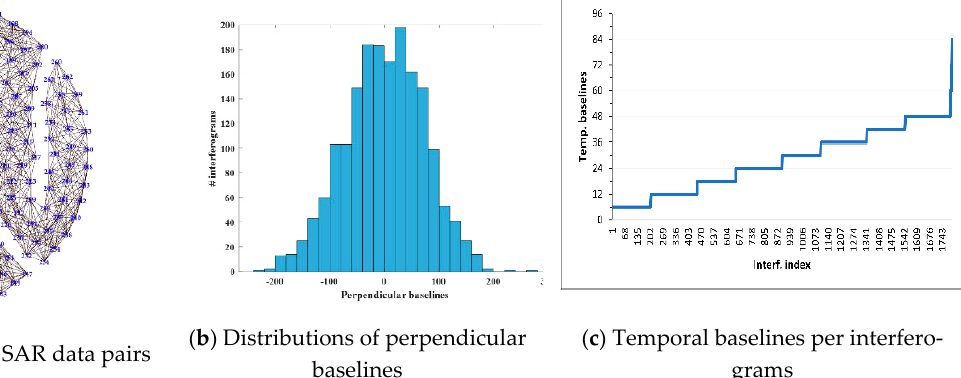
Figure 1. The spatial (b) and temporal (c) baselines information of selected interferograms. The temporal resolution of interferograms processed is either 6 or 12 days. Nodes and edges in (a) refer to images and interferograms, respectively.